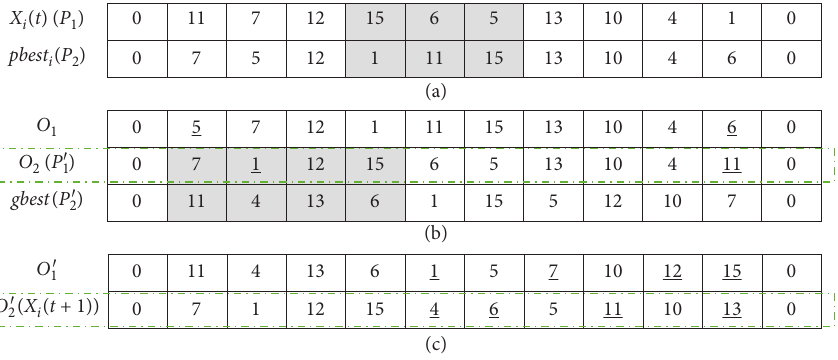
Figure 7: An example for particle crossover operator. The grey segments are the chromosomes selected to cross.